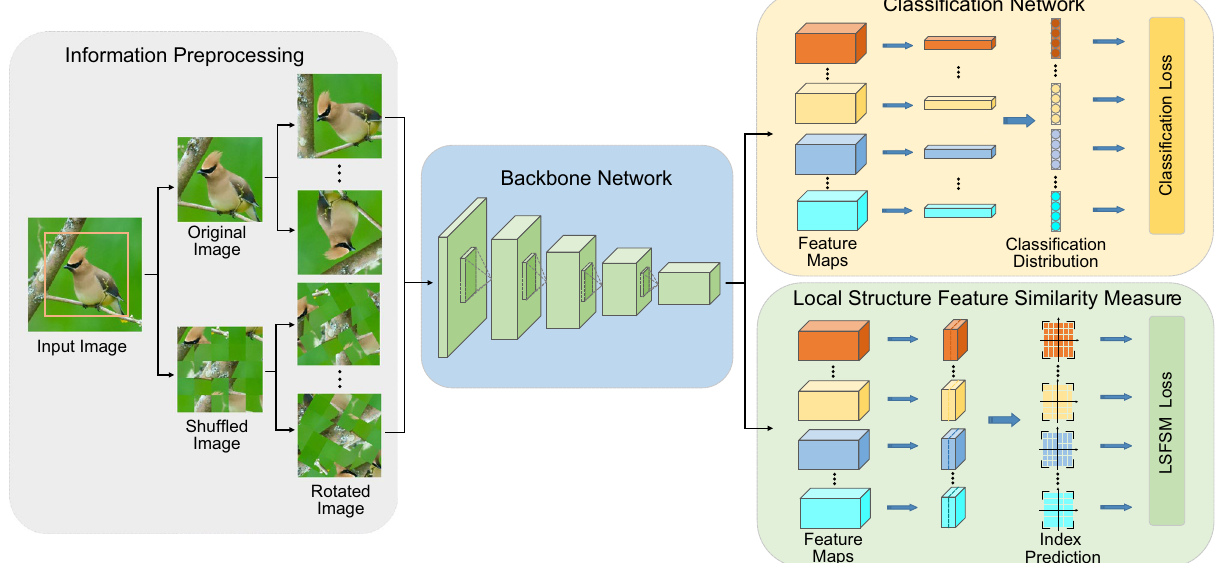
Figure 1. The overall pipeline of our proposed LSI learning framework. (1) Information preprocessing: rotate the input and shuffled images. (2) Backbone classification network: extract the basic feature maps. (3) Classification network: classify images into fine-grained categories. (4) LSFSM: measure local structure features similarity of different images.